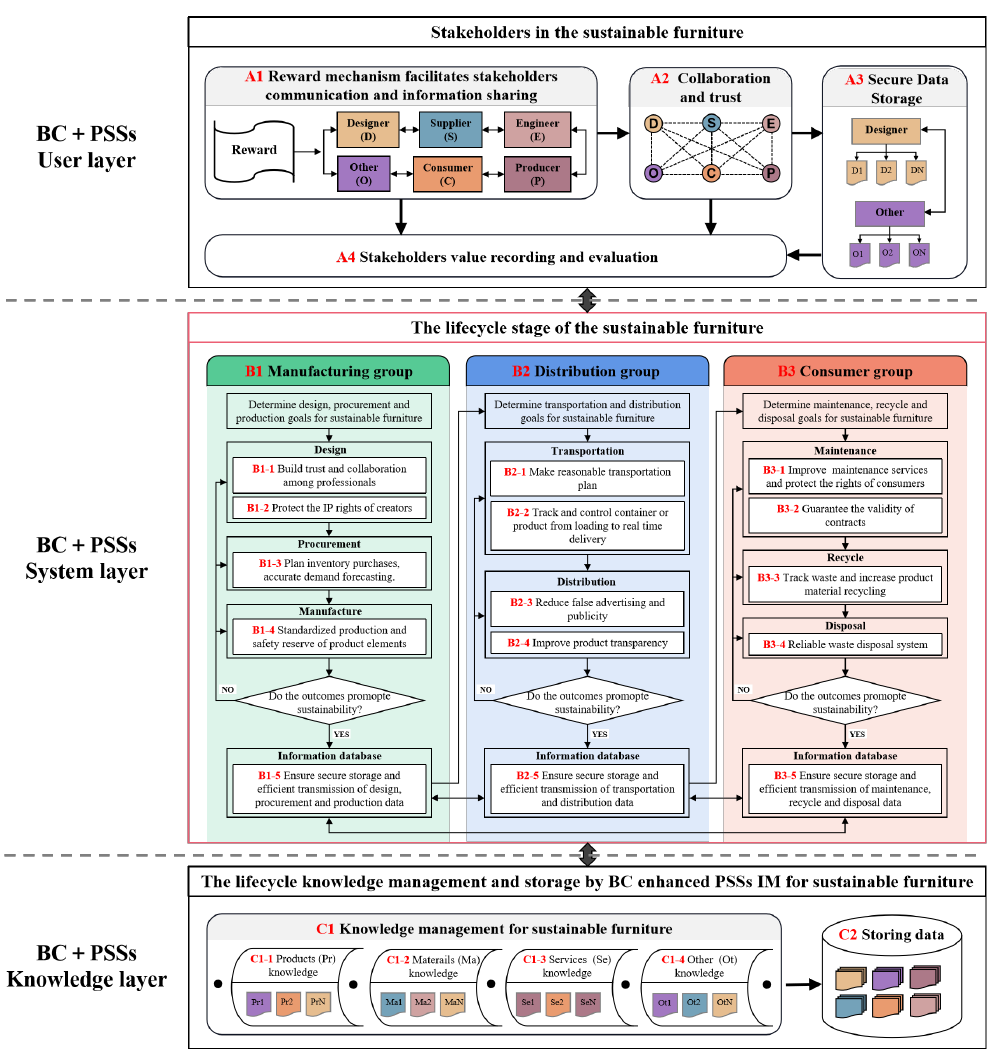
Figure 14. The updated high-level BC-PSSs framework (generated by authors).